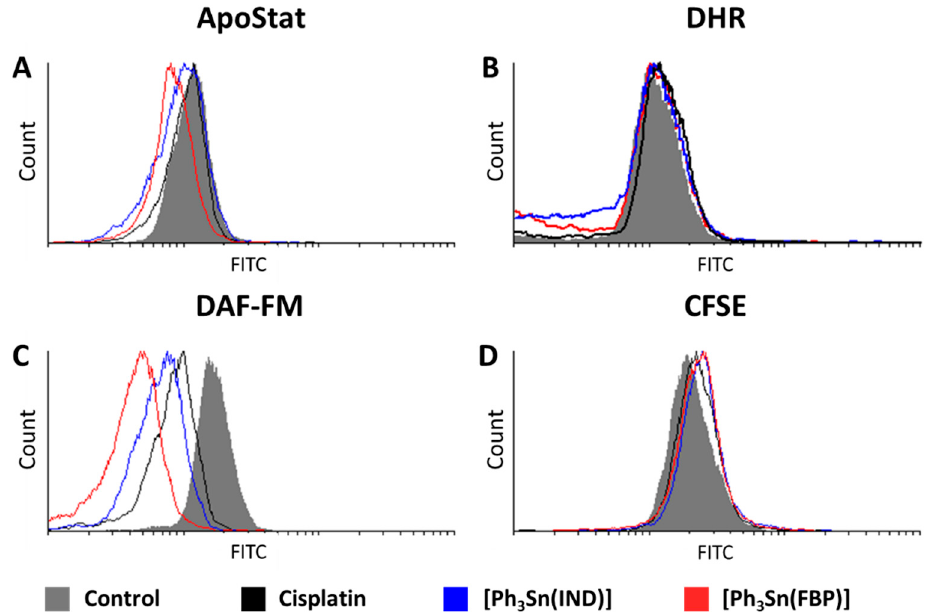
Figure 5. Effect of organotin(IV) complexes ([Ph 3 Sn(IND)] and [Ph 3 Sn(FBP)]) and cisplatin on BT-474 cells: ( A ) caspase activation, ( B ) ROS/RNS production, ( C ) NO production, and ( D ) cell proliferation potential.